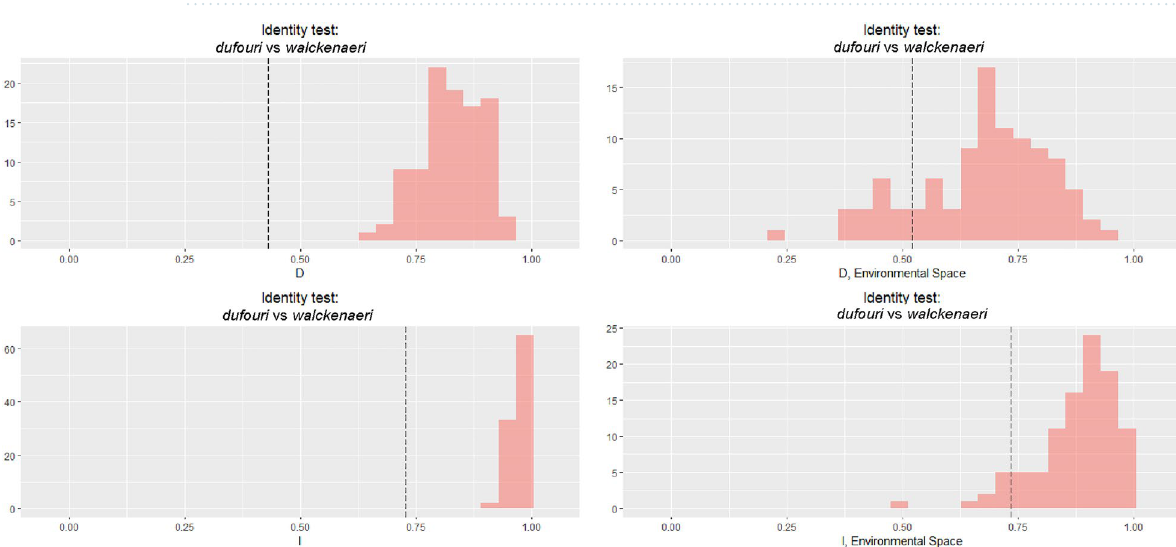
Figure 3. Results of identity test for the two clades ( dufouri and walckenaeri ) across the geographical and environmental spaces . Panels show histograms of 100 simulations of identity tests using two different metrics; the Schoener’s D and Warren’s I. Dotted lines indicate observed values. The figure is created using ENMTools 1.0.4 (https:// github. com/ danlw arren/ ENMTo